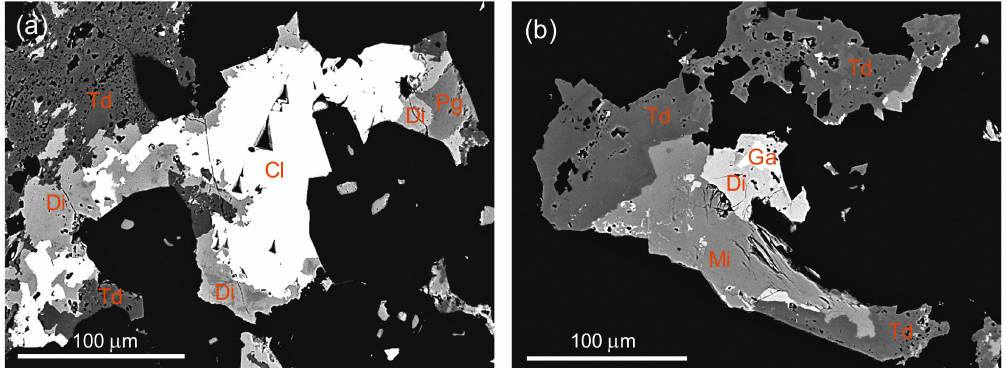
Figure 20. ( a ) Diaphorite (Di) in association with clausthalite (Cl), pyrargyrite (Pg), and Ag-rich tetrahedrite (Td); ( b ) diaphorite (Di) associated with galena (Ga), miargyrite (Mi), and Ag-rich tetrahedrite (Td); both back-scattered electron (BSE)